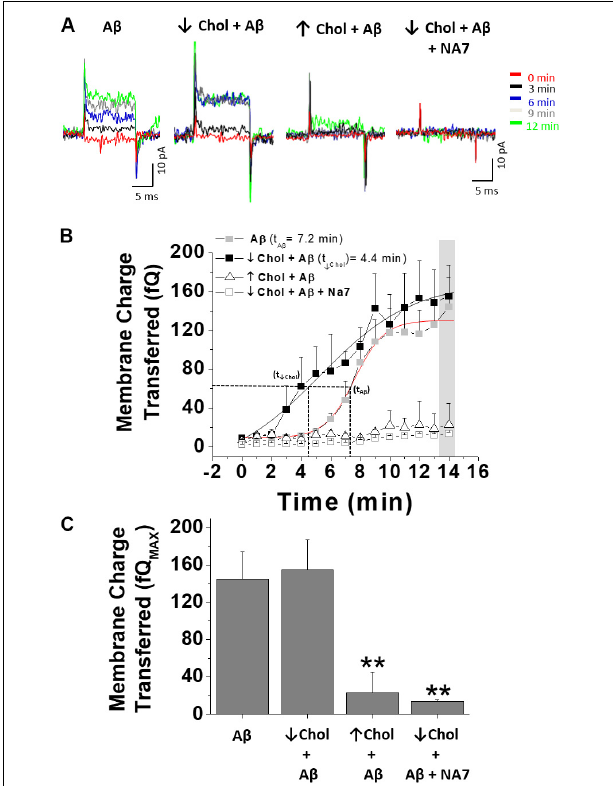
FIGURE 4 | The effect of A β on membrane integrity depends on the level of cholesterol. (A) Representative traces of capacitive currents recorded at different times after increasing or decreasing relative levels of cholesterol in HEK-293 cells. (B) Time course of A β -induced perforation for each of the conditions described in (A) showing the kinetic of the perforation process and how this effect changes when membrane-cholesterol levels are modified. (C) Quantification of membrane charge transferred at the end of the registration period. The effects of A β in a cholesterol-depleted condition were blocked by the NA7 peptide. Bars represent the mean ± SEM. Asterisk denotes ∗∗ p < 0.005.